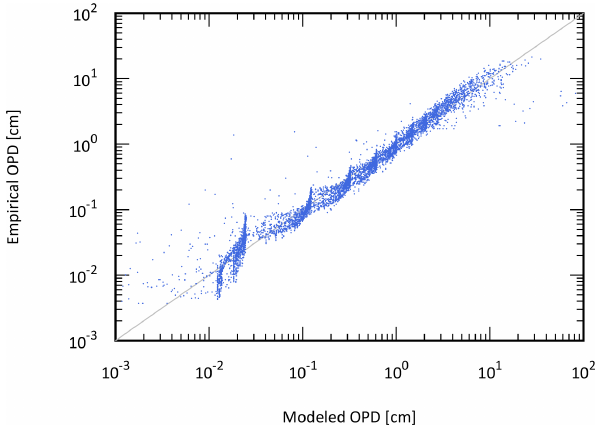
Figure 8. The correlation between the simulated OPD and the OPD obtained from an empirical relationship of Eq. (48) ( n = 5652). The gray line denotes the 1 : 1 line ( r 2 = 0 . 9595).